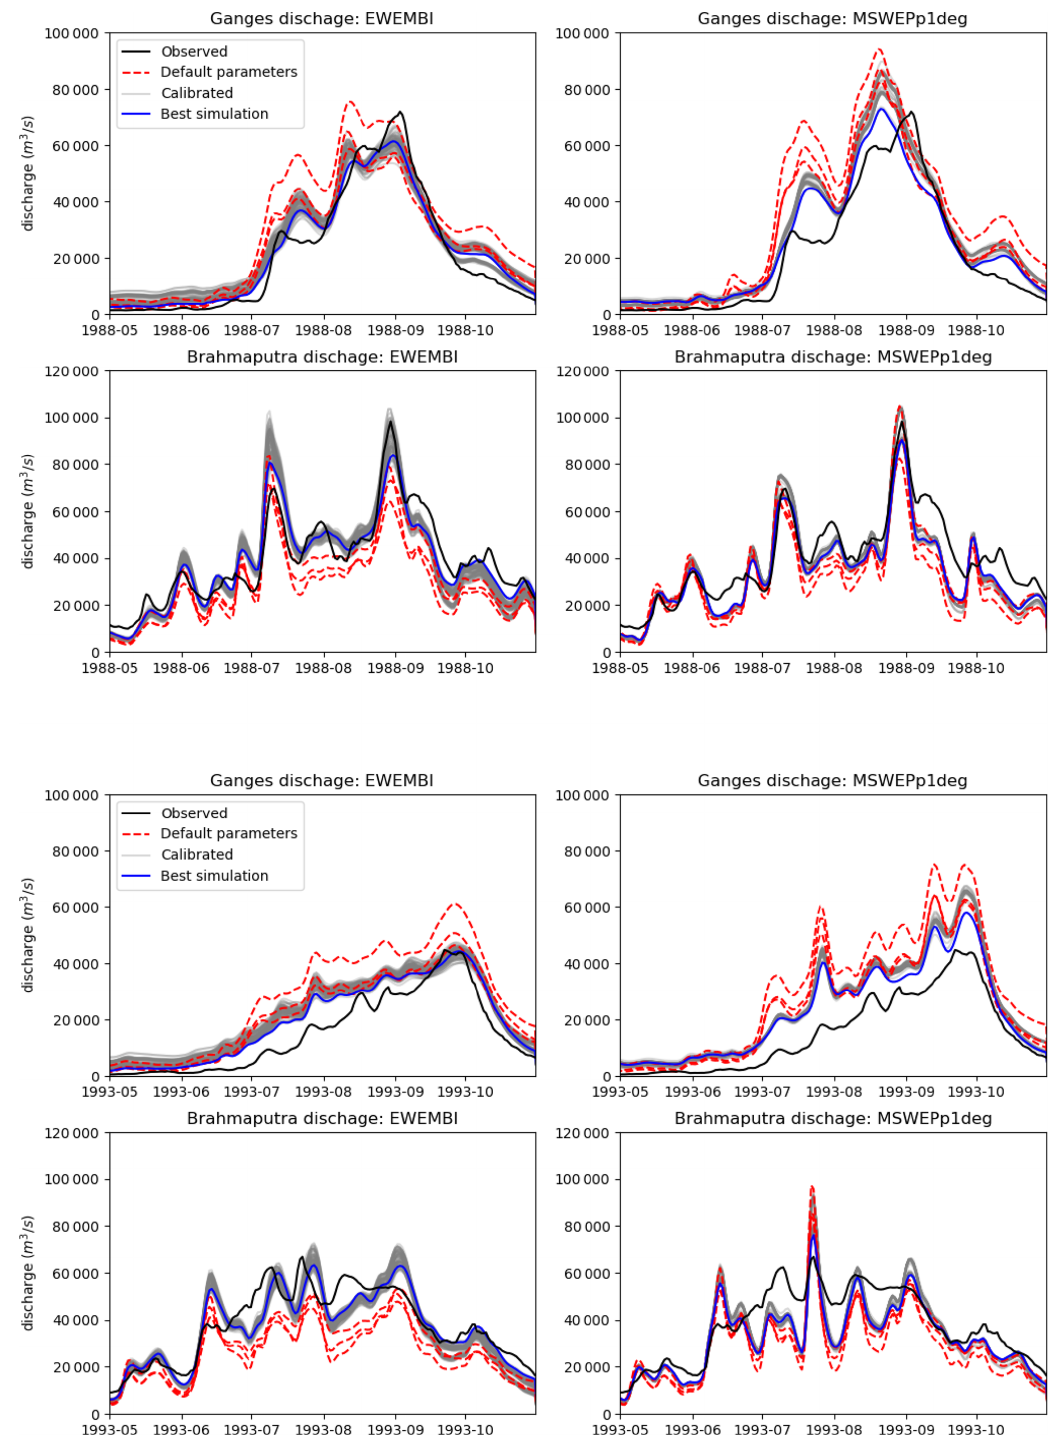
Figure 9. Yearly streamflow for 1988 (top) and 1993 (bottom). Each of these plots has four panels with EWEMBI-simulated streamflow on the left and MSWEPp1deg-simulated streamflow on the right. Top panels show streamflow for the Ganges and bottom panels show streamflow for the Brahmaputra River. In each of the panels the observed station discharge is compared to different simulated flows. Red dashed lines show simulations using default FUSE parameters. Grey lines show simulations using a range of different calibrated parameters. Blue lines show the simulation with the highest Kling–Gupta efficiency score calculated over the 1980–2013 period (“Best